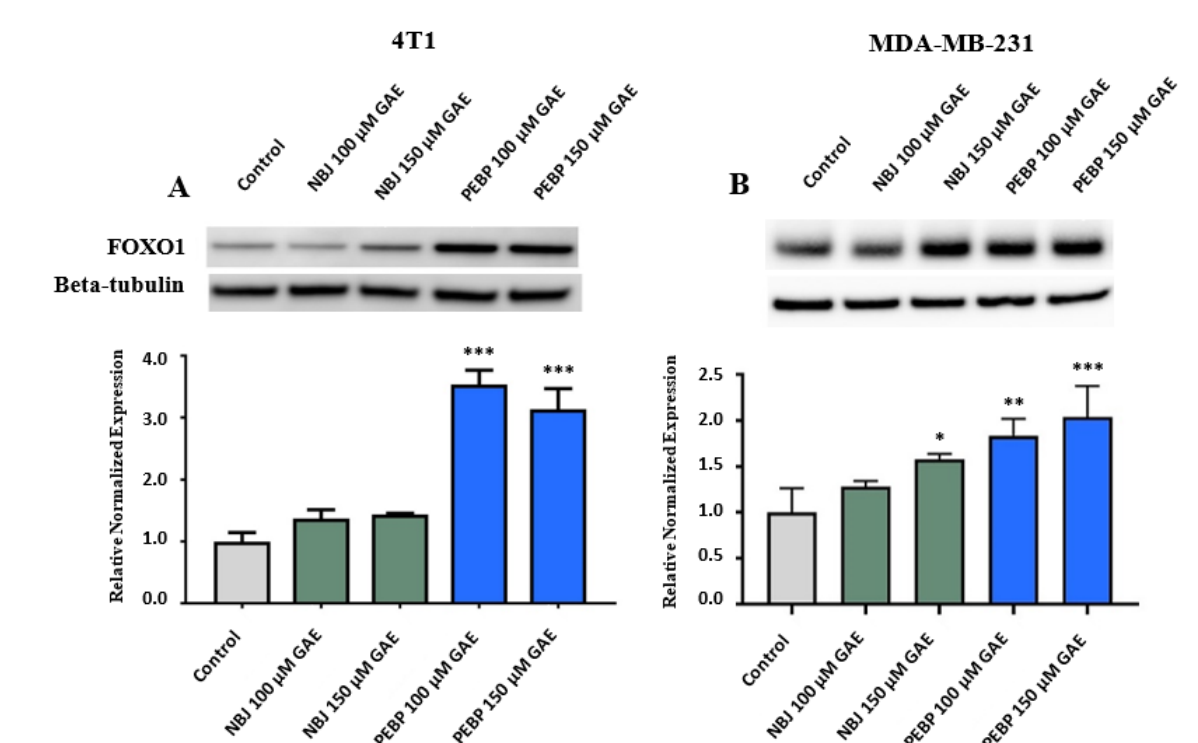
Figure 3. Relative expression of FOXO1 in ( A ) 4T1 and ( B ) MDA-MB-231 cells exposed to 100 µM or 150 µM gallic acid equivalent (GAE) of either polyphenol-enriched blueberry preparation (PEBP) or non-fermented blueberry juice (NBJ) for 24 h. The control consisted of using the same vehicle media used for treatment groups. Western blot images are from one representative experiment. One-way ANOVA and Bonferroni’s post-hoc tests were used to compare groups. All values are mean ± SEM of 3 separate experiments. * p < 0.05, ** p < 0.01 and *** p ≤ 0.001 vs. control.